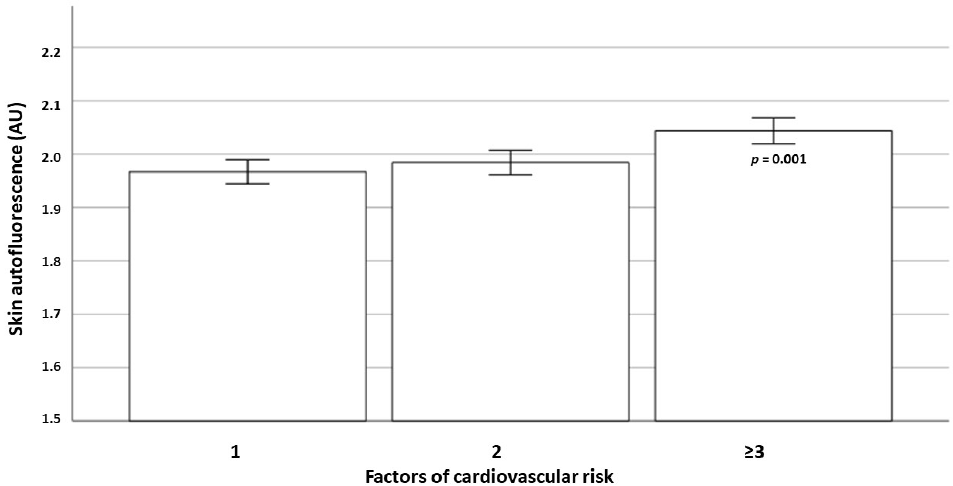
Figure 2. Results of the skin autofluorescence values in the entire population of the ILERVAS project according to the number of cardiovascular risk factors (a history of smoking habits, hypertension, dyslipidemia and prediabetes).